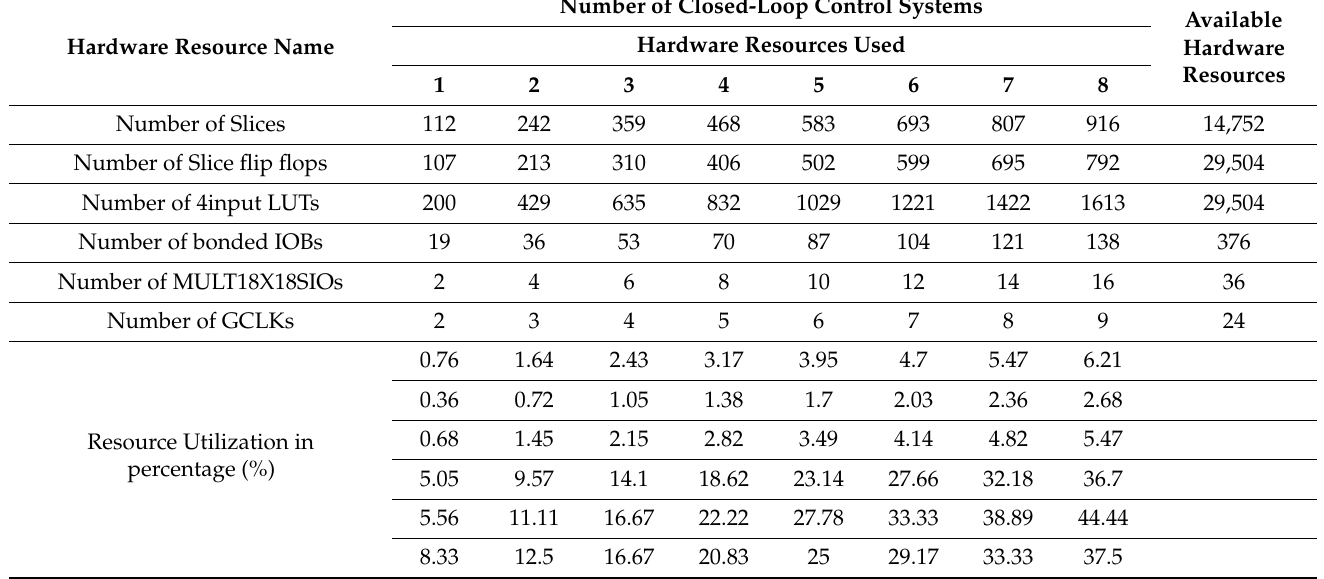
Table 1. Utilization of FPGA hardware resources for different numbers of closed-loop control systems using XC3S1600E-4-FG484 (SPARTAN3E).